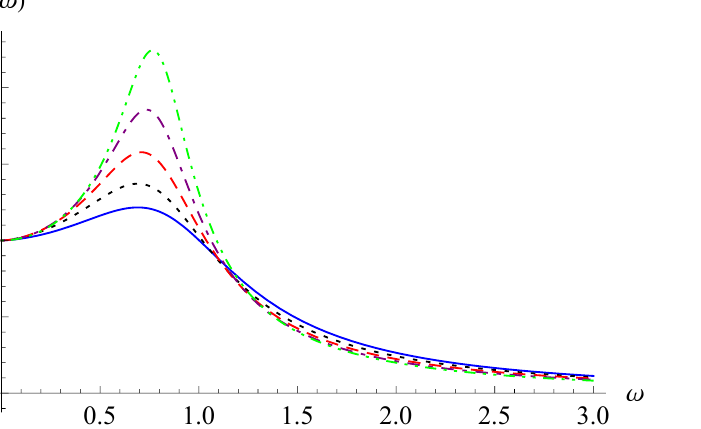
Figure 3. Frequency–amplitude curves for k = m = 1, c = 0.5, η = 0.5, and λ = 1.1 (solid line), 1.3 (dotted line), 1.5 (dashed line), 1.7 (dot-dashed line), or 1.9 (dot-dot-dashed